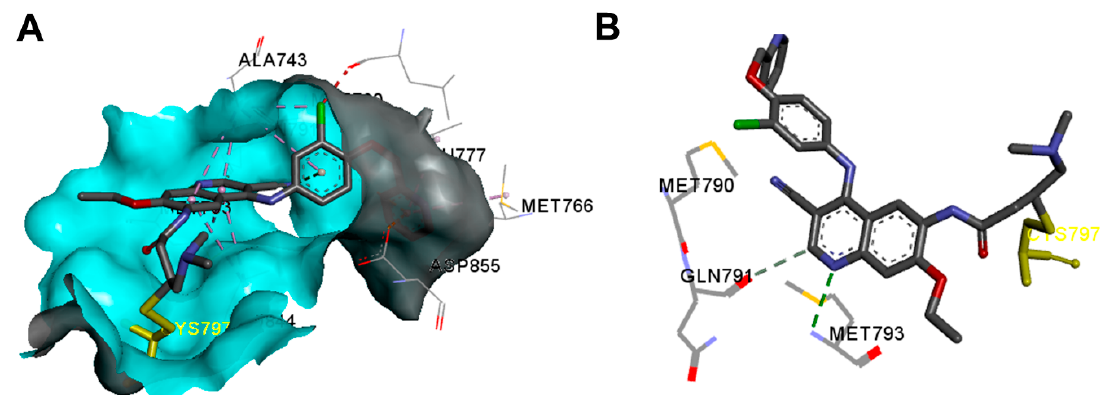
Figure 45. Binding modes of neratinib (shown as sticks) into EGFR kinase domain T790M mutation (pdb: 2JIV): ( A ) 3D binding mode, receptor shown as hydrogen bond surface; ( B ) 2D binding mode showing the covalent bond with Cys797 and the hydrogen bond interactions; the figure was generated using Discovery Studio Visualizer (V16.1.0.15350).